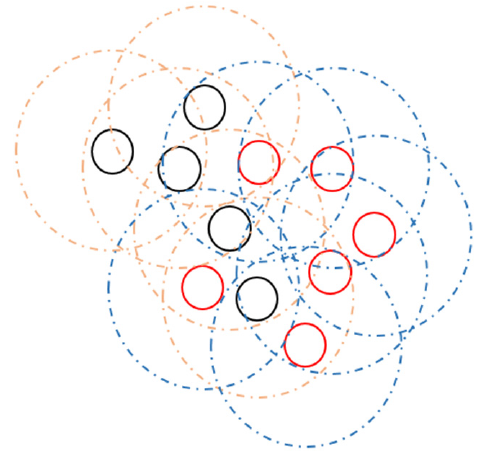
Figure 15. Different goals in the workspace.